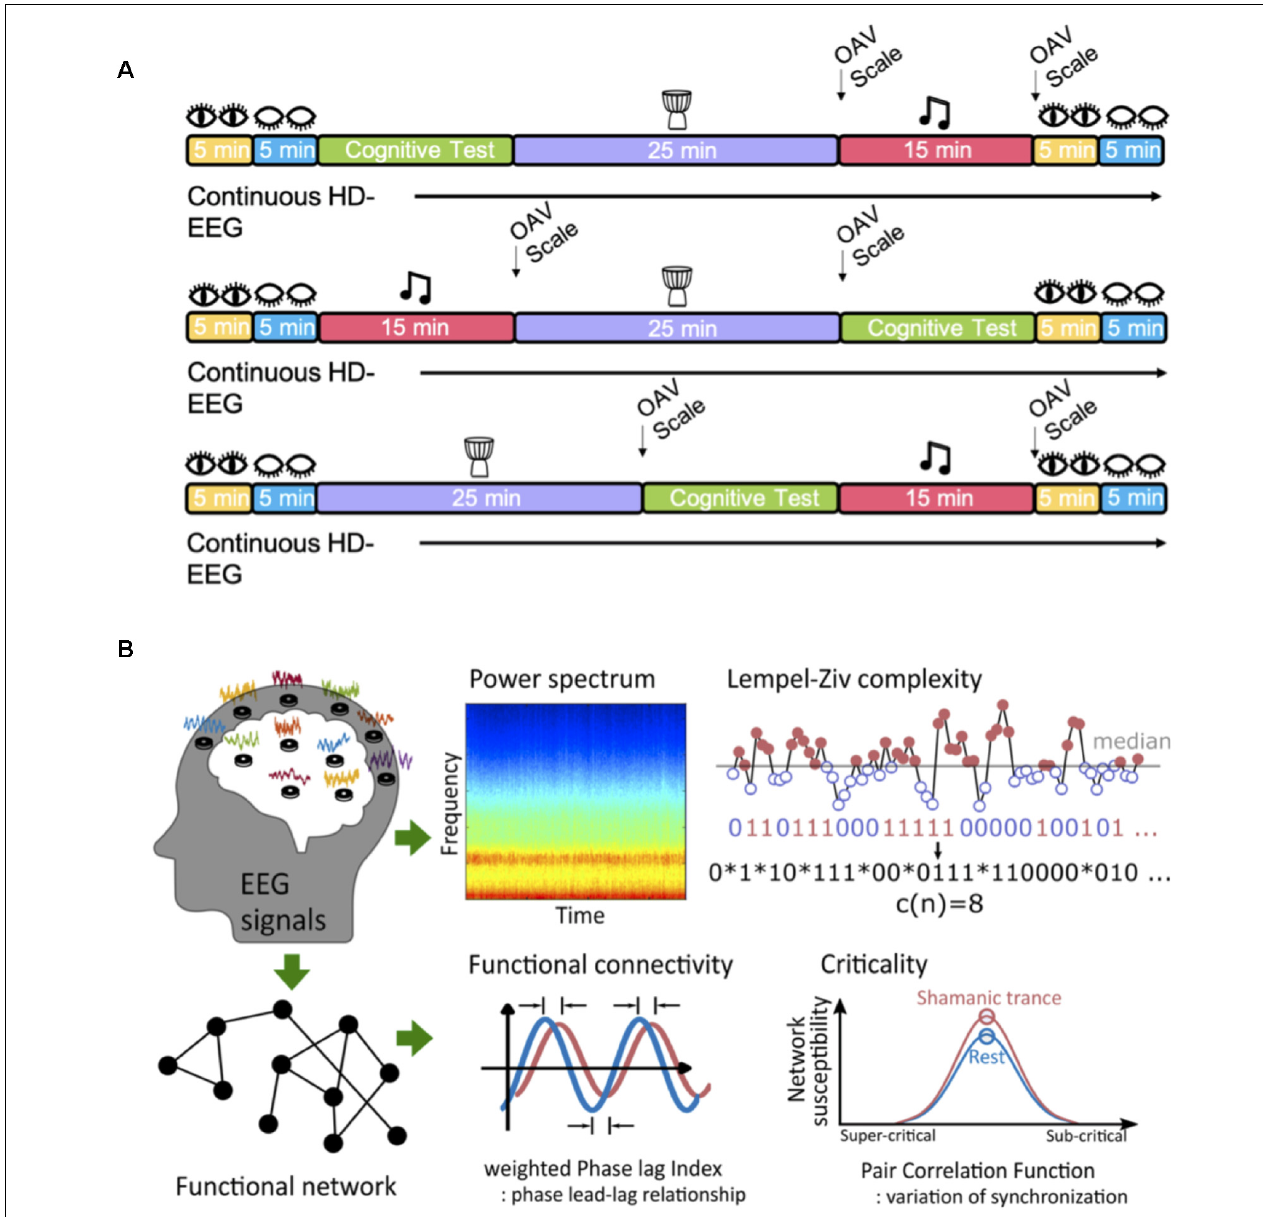
FIGURE 1 | Study design. (A) Example timelines of a typical study day based on a given experiment block. Each individual was randomized to the order they underwent cognitive testing, shamanic drumming, and classical music listening. Eyes open and eyes closed resting periods occurred at the beginning and end of the experimental day. The Altered States of Consciousness Questionnaire, known as the OAV scale, was administered following classical music and shamanic drumming. (B) All participants underwent high-density electroencephalogram (EEG) recordings during drumming, classical music, and periods of eye-opening and closure. Following preprocessing, EEG signals were used to compute subsequent measures within each frequency band, including the power spectrum, functional connectivity measured by weighted Phase Lag Index, signal diversity measured by Lempel-Ziv complexity (image referenced from Leemburg and Bassetti, 2018), and criticality measured by the pair correlation